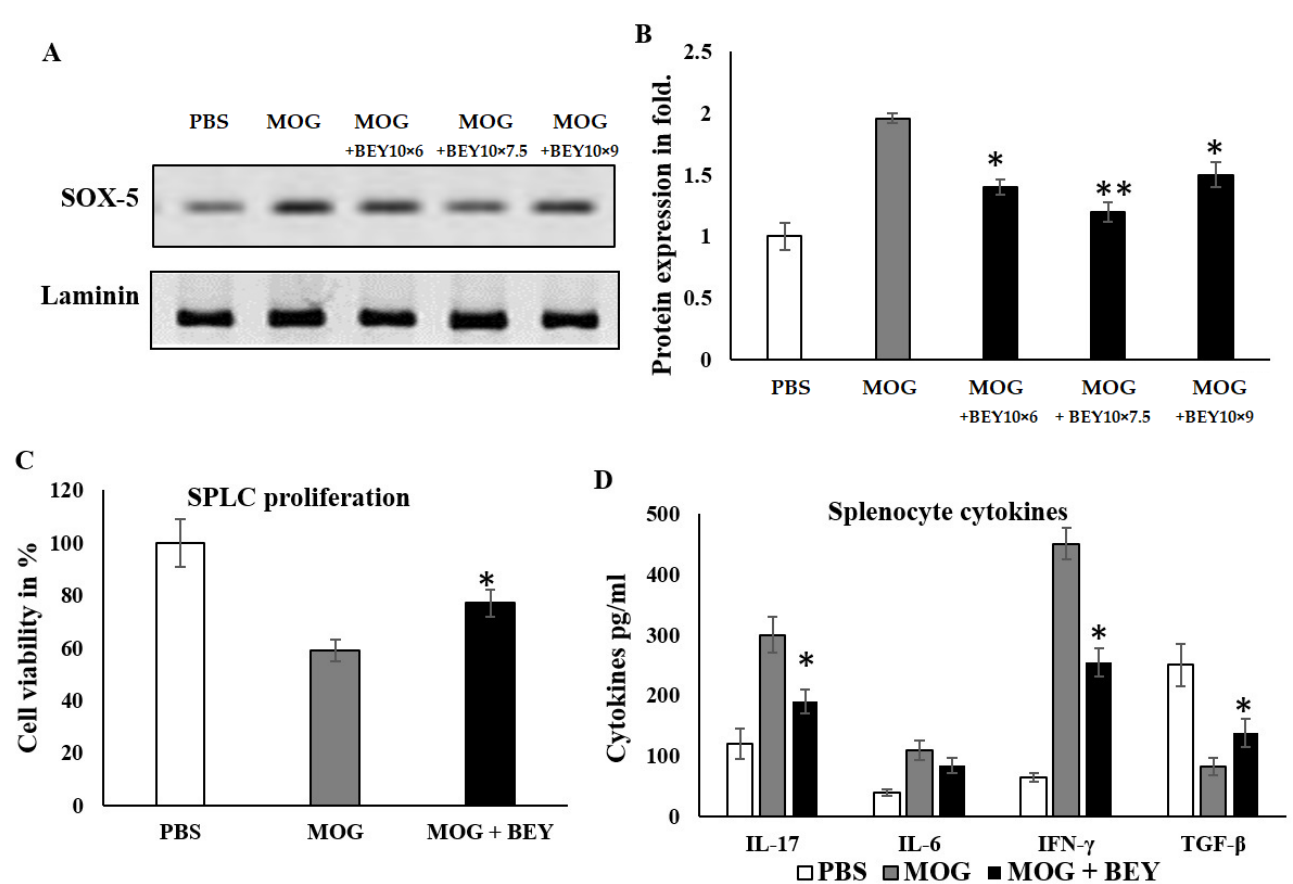
Figure 1. The effect of BEY on MOG-stimulated splenic lymphocytes. ( A , B ) Total lymphocytes were collected from naïve mouse spleens and immunized with 2 ng/mL MOG for 4 h and treated with BEY for 2 h. Treated cells were evaluated for SOX5 transcriptional factors using Western blot. ( C , D ) The optimum BA for yogurt is 10 × 7.5, which was further used in splenocyte viability testing with the SRB assay. The level of cytokine secretion in splenocytes was quantified using ELISA kit. The values were expressed as pg/mL and each group ’s data were displayed as mean ± SD. One-way ANOVA followed by post hoc t -test was used for statistical analysis (significant at * p ≤0.05, ** p ≤ 0.01).